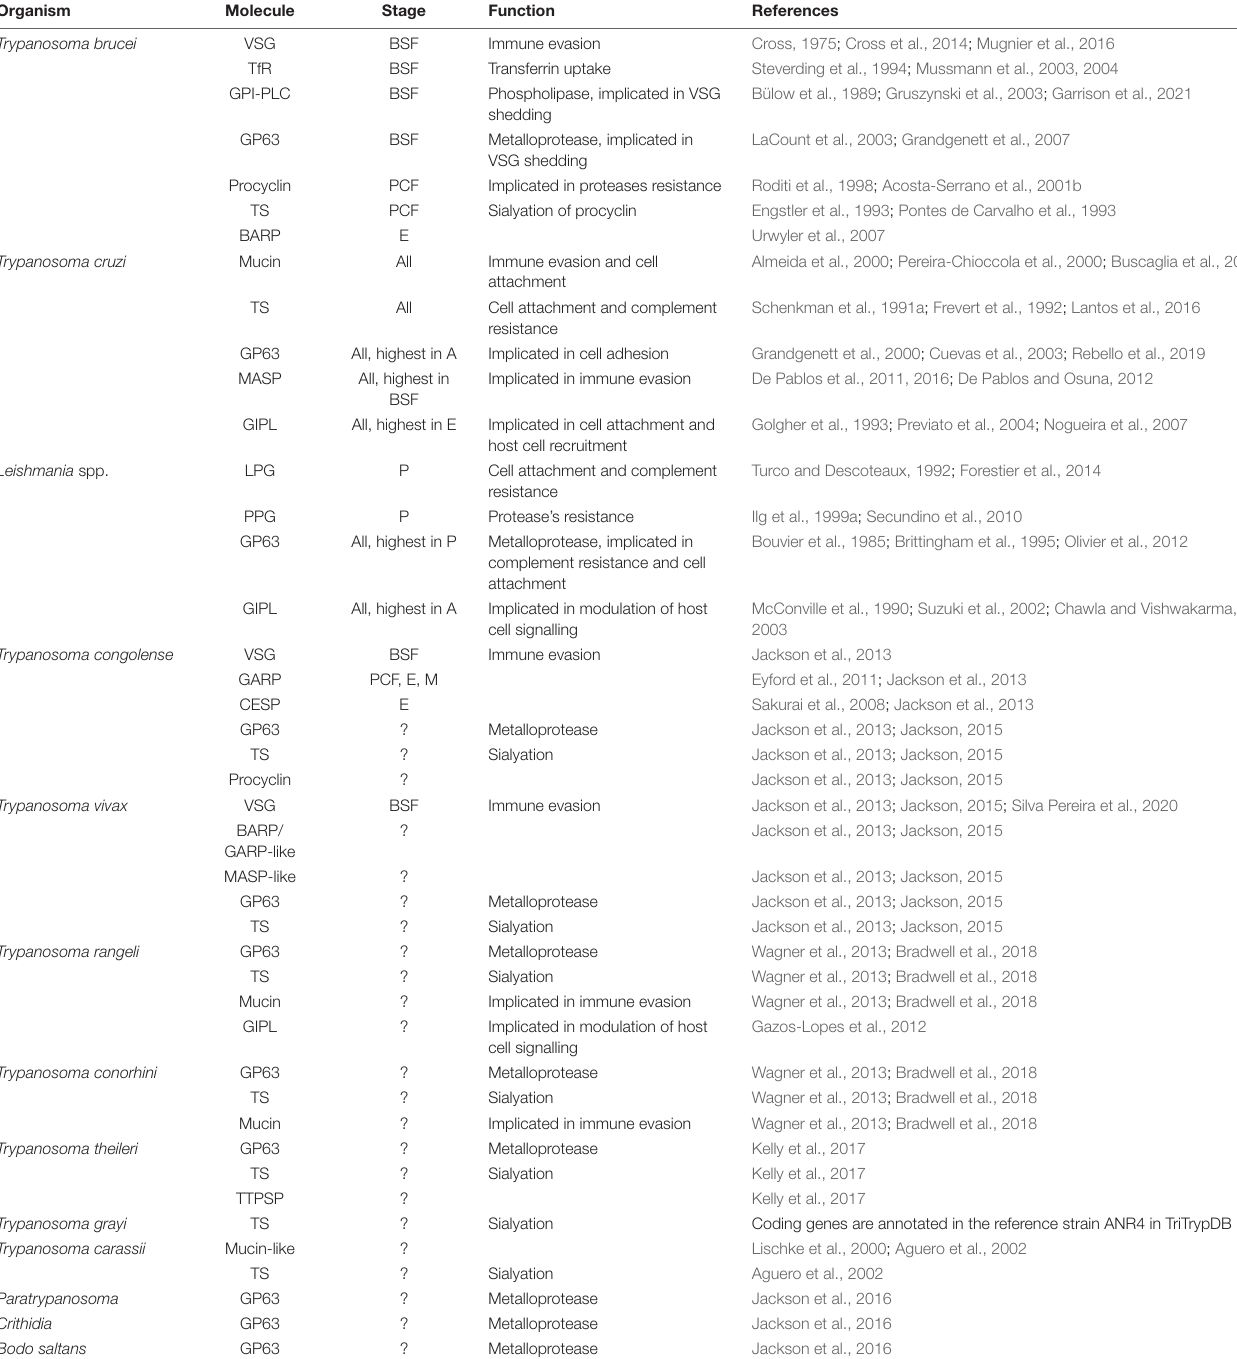
TABLE 2 | Glycosylphosphatidylinositol-anchored surface molecules of trypanosomatids.